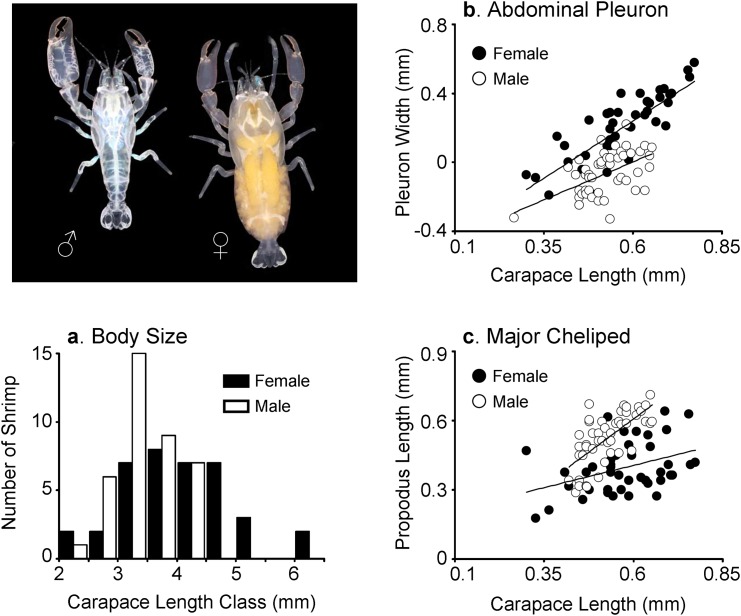
Sexual dimorphism in Pontonia manningi.(a) Size frequency distribution of body size (CL) in males and females. Measurements are in mm. (b) Relative growth of major cheliped propodus length as a function of carapace length in males and females of Pontonia manningi. (c) Relative growth of pleuron of second abdominal segment as a function of carapace length in males and females of Pontonia manningi. Linear regression equation obtained previous log-log transformation of the data are shown for each sex on Table 2. The photograph on the top left shows a male-female couple of Pontonia manningi retrieved from a single oyster.